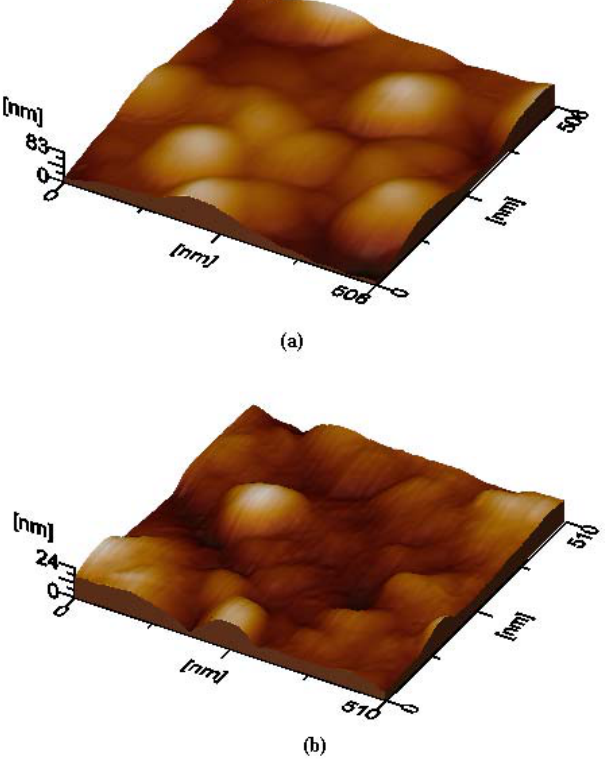
Figure 4. 3D-micrographs obtained by AFM, showing the surface morphology of thin films deposited on quartz slices from: ( a ) The Li Li PcL2 2